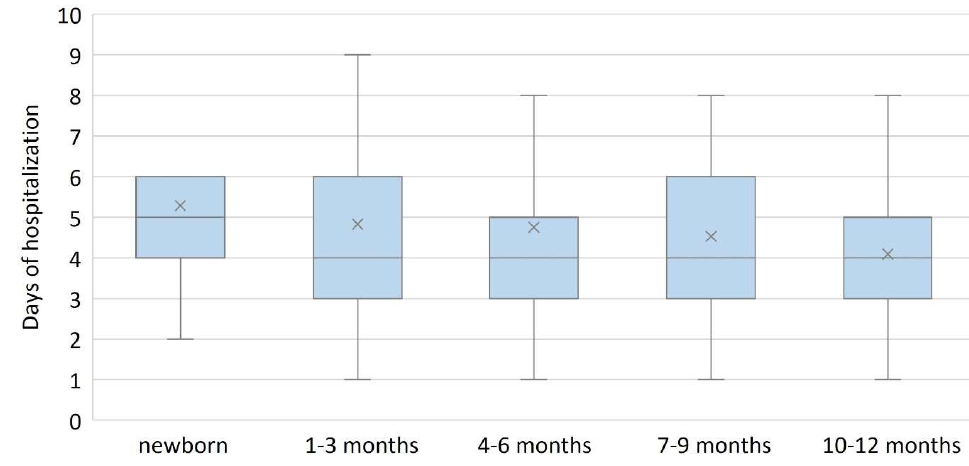
Figure 3. Number of days of hospitalization according to age group. The length of hospitalization was longer in infants between 1 and 3 months. Box and whiskers plot represent the 25th and 75th percentiles (box), the median ( × ) and the range (whiskers).